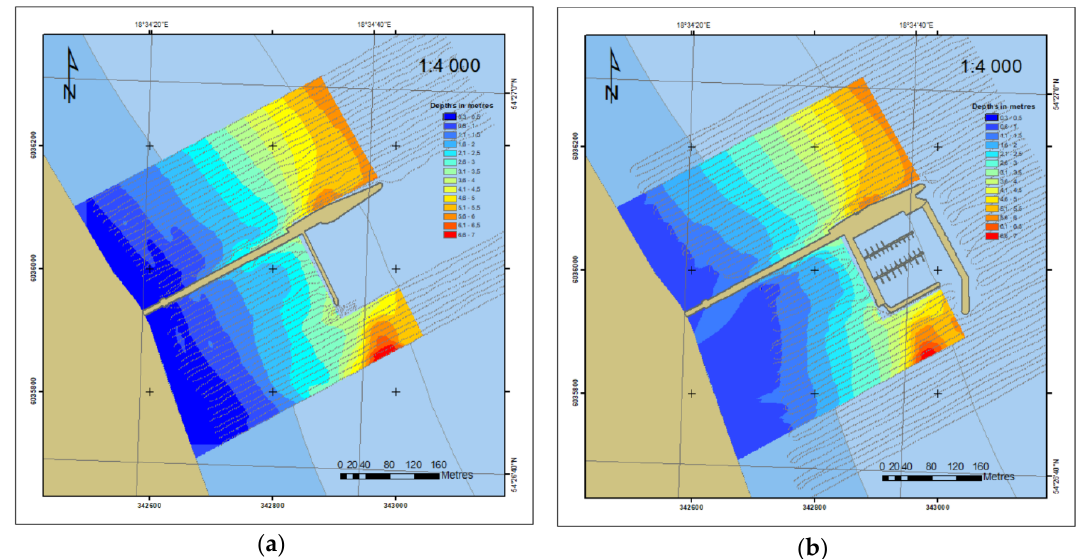
Figure 8. 2D bottom model based on the 2010 ( a ) and 2012 ( b ) surveys.